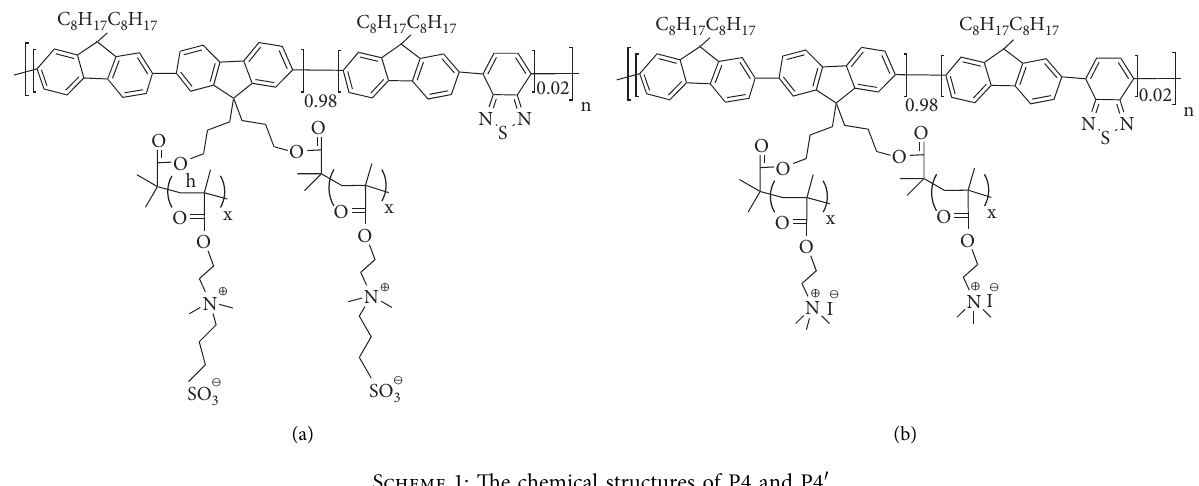
Scheme 1: The chemical structures of P4 and P4 ′